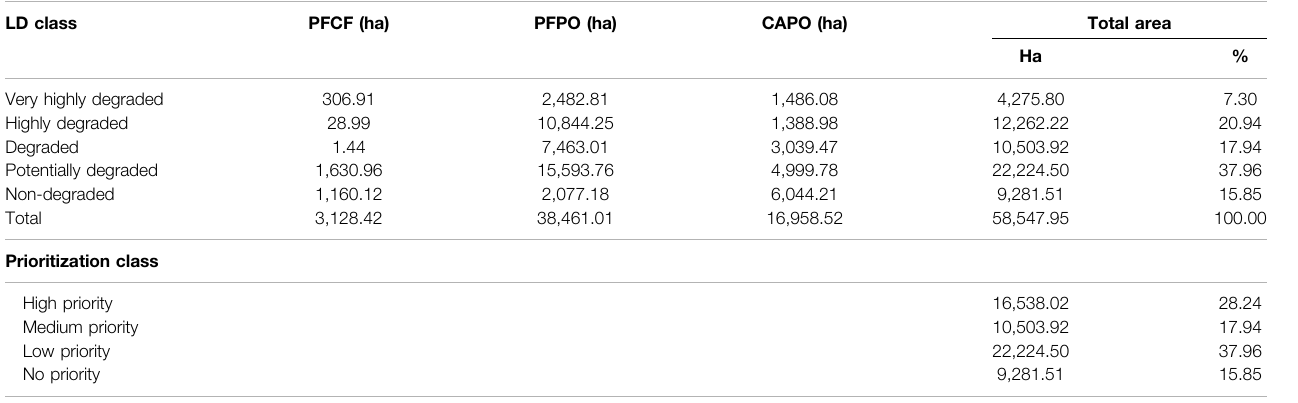
TABLE 3 | LD classes and prioritization classes for handling watershed